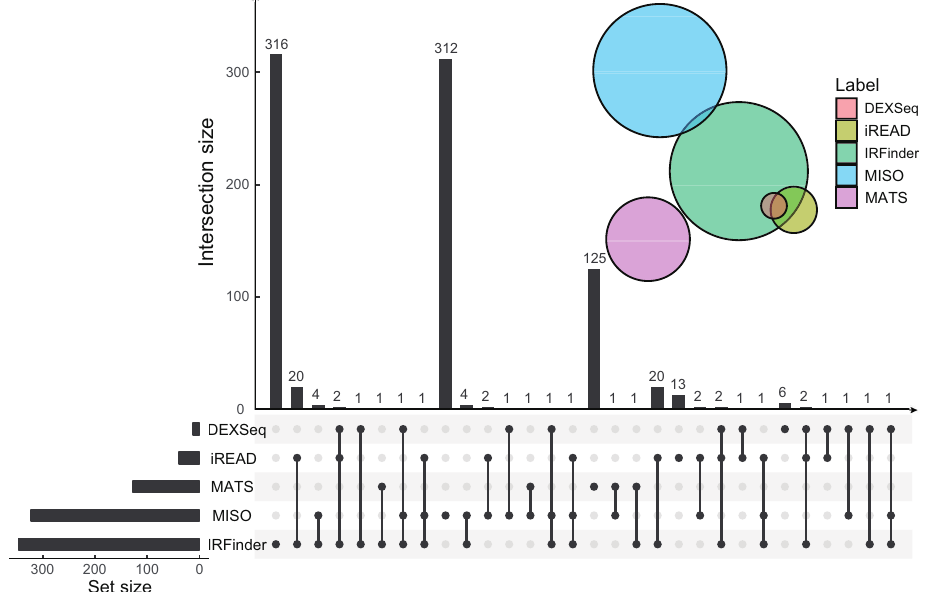
Fig. 5 Venn and UpSet diagram showing the comparison of significantly differentially expressed introns obtained by the six methods on the APP mutant mouse